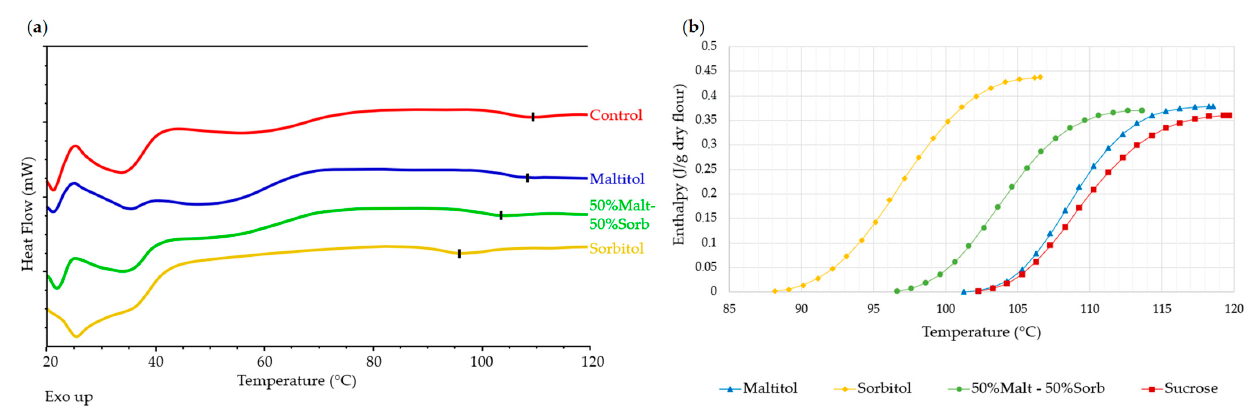
Figure 7. Examples of thermograms obtained by calorimetry with the substituted and reference doughs ( a ) and mean enthalpy of starch melting as a function of the temperature in the control and no-added-sugar biscuit doughs ( b ) ( n = 3). Dough at initial water content. Sucrose substitution did not seem to have an e ff ect on enthalpy, except for the sorbi- tol dough, which exhibited a slightly higher enthalpy (0.38 J/g dry fl our (d.f.) vs. 0.30 J/g